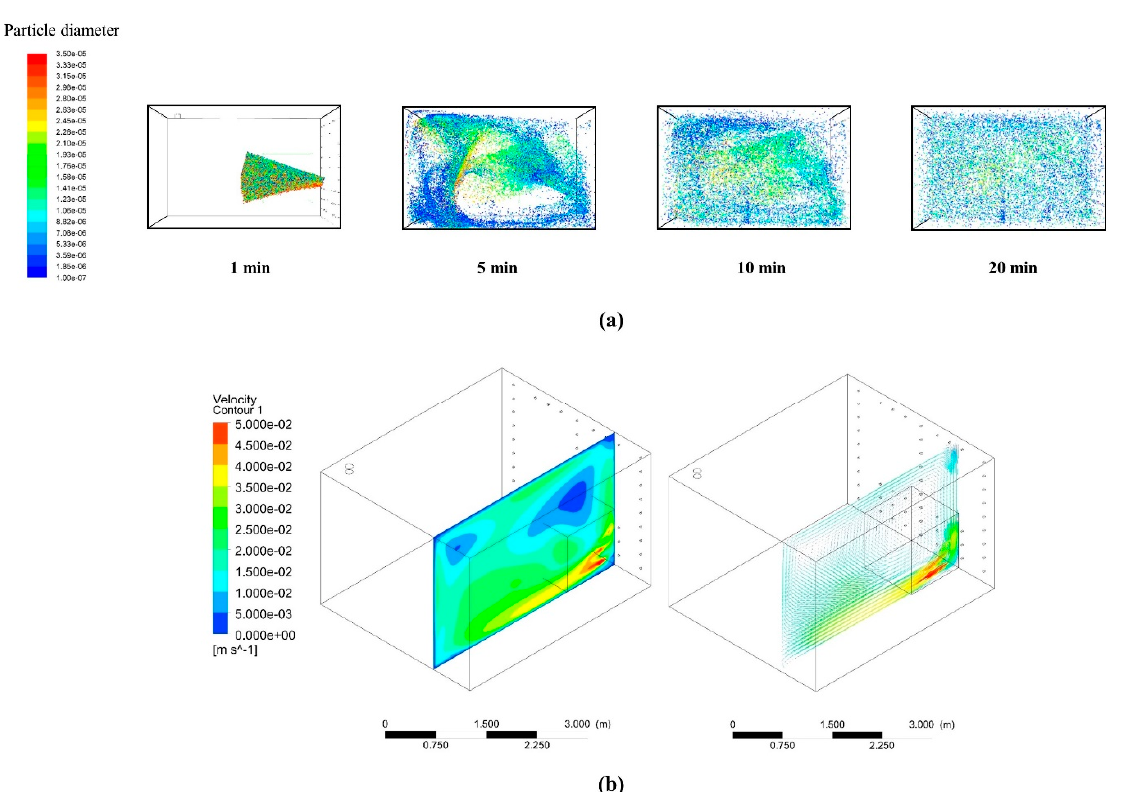
Figure 8. The dynamic behavior of sprayed biocide aerosol over simulation time ( a ). Visualization of velocity contour and vector in chamber ( b ). The dynamic behavior of sub ‐ micro aerosol is dependent on turbulence flow.